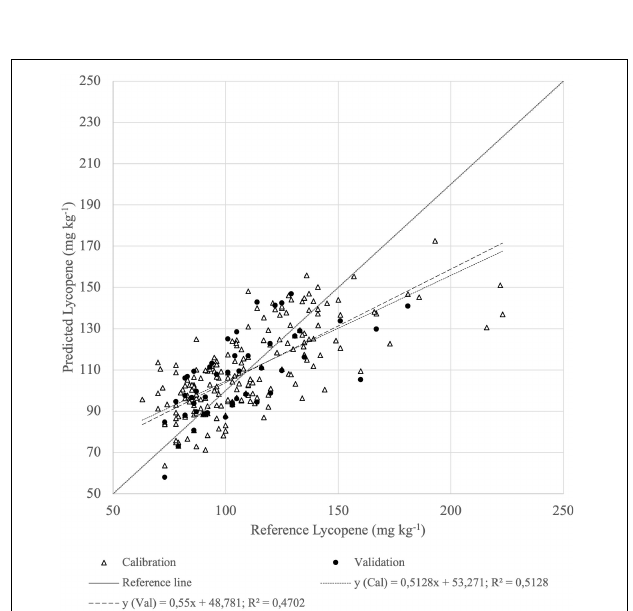
FIGURE 6 | Calibration (Cal) and validation (Val) set of reference ( n = 99) vs. predicted ( n = 33) SSC of intact tomato fruits derived from the best PLSR model from absorbance of Vis-NIR spectra with MSC preprocessing.